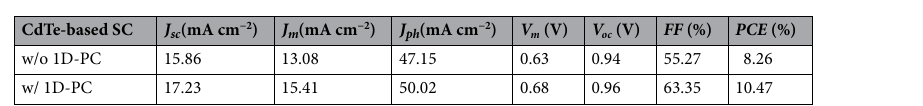
V characteristics of ( a ) FTO/SnO V and P Figure 6. J − − MoO